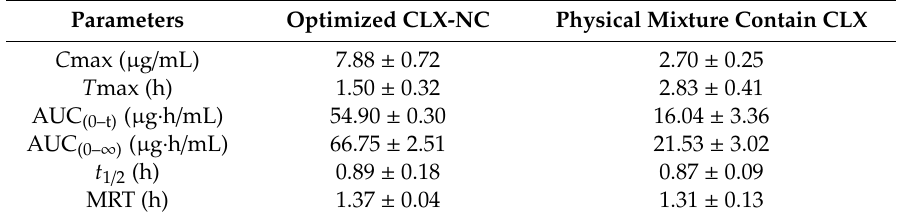
Figure S1: Viscosity values of the suspension containing di ff erent polymer stabilizer. Figure S2: E ff ects of critical material attributes (CMAs) and critical process parameters (CPPs) on critical quality attributes (CQAs) of CLX-NC.CMAs and CPPs include (A) PVP VA64 concentration, (B) SDS concentration, (C) milling times, and (D) balls size. Figure S3: Perturbation plots showed the e ff ects of factors X1 (A), X2 (B) and X3 (C) on the responses Y 1 the response ofPDI, Y 3 is the response of zeta potential (mV). Figure S4: Design space (yellow overlap region) of CLX-NC for the desired critical quality attributes after evaluation of process and formulations variables. Figure S5: Particle size distributions of (A) optimized CLX-NC andCLX-NC after six mouthsstorage at (B) 4 ◦ C and (C) 25 ◦ C. Table S1: Preliminary risk assessment matrix elucidating the impact of critical material attributes (CMAs)